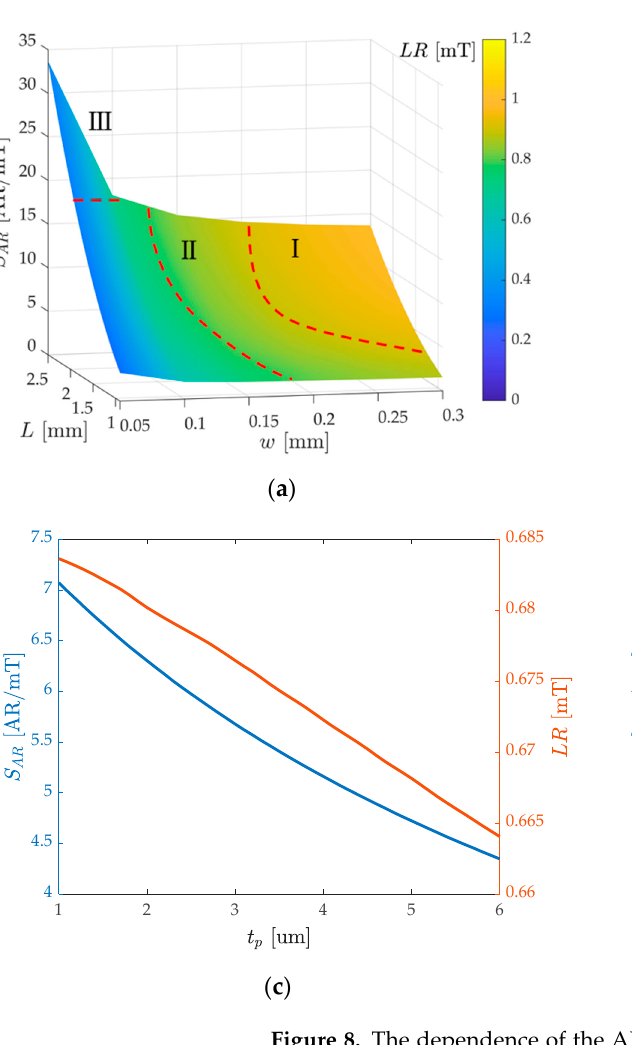
( b ) Figure 7. Selecting the projection surface of the saturation magnetization 𝑀 (cid:3046) = 0.75/𝜇 (cid:2868) from Figure 6b: ( a ) the dependence of the AR sensitivity and linear range on the magnetostrictive film thickness 𝑡 (cid:3040) ; ( b ) the dependence of the biased magnetic field and the linear range on the 𝑡 (cid:3040) . In terms of the area dimensions of the WCR, as shown in Figure 8a, selecting 𝑡 (cid:3040) = 2.0 µm, 𝑀 (cid:3046) = 0.8/𝜇 (cid:2868) , 𝜆 (cid:3046) = 130 ppm, the response of the length and width of the cantile- ver beam to the AR sensitivity and LR is studied. The surface can illustrate obviously that the larger cantilever beam length 𝐿 and the smaller width 𝑤 can bring higher AR sensi-